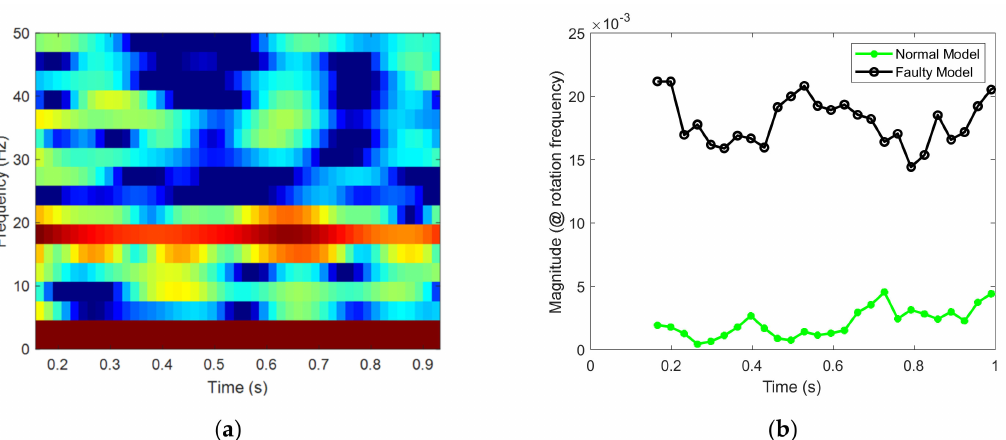
Figure 6. Case without impulsive noise. ( a ) STFT of envelope of faulty signal model. ( b ) Magnitude at rotational frequency of 18 Hz over time with 0.33-s-length time window and 90%